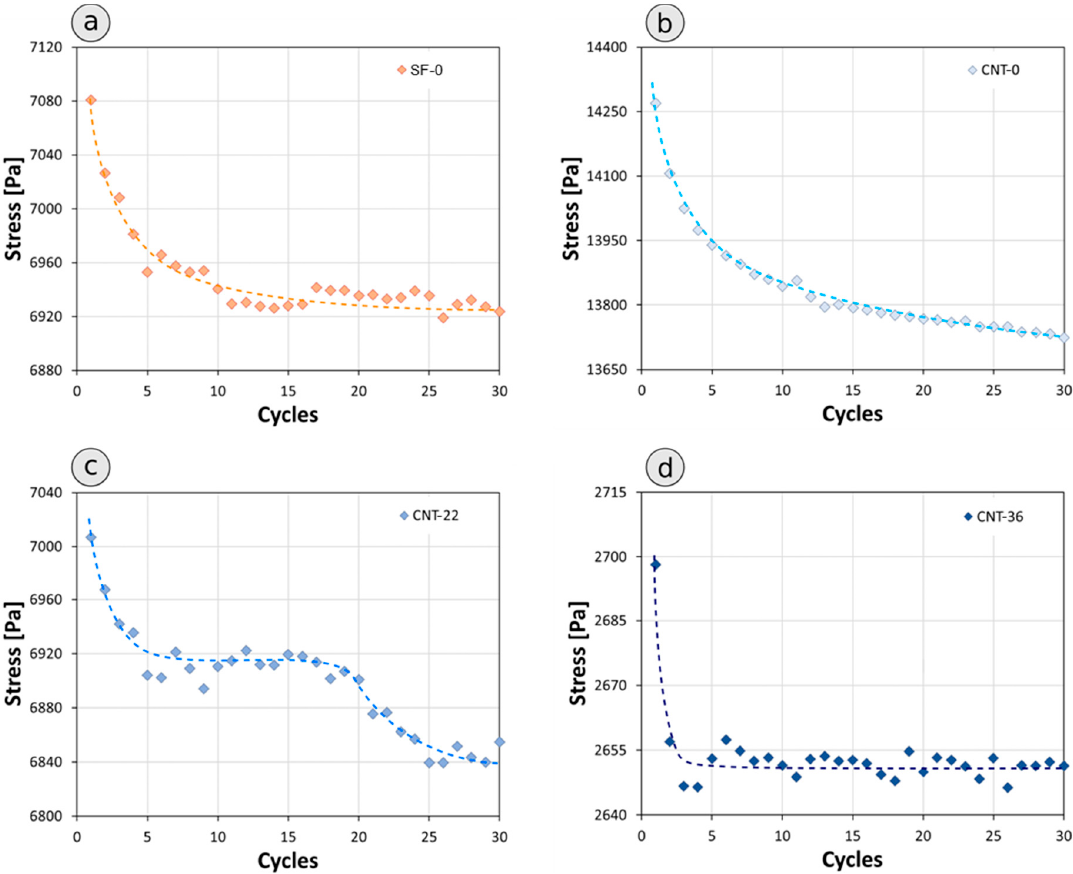
Figure 10. Maximum stress of ( a ) SF-0, ( b ) CNT-0, ( c ) CNT-22, and ( d ) CNT-36 at an increasing number of cycles (50% ε max ).